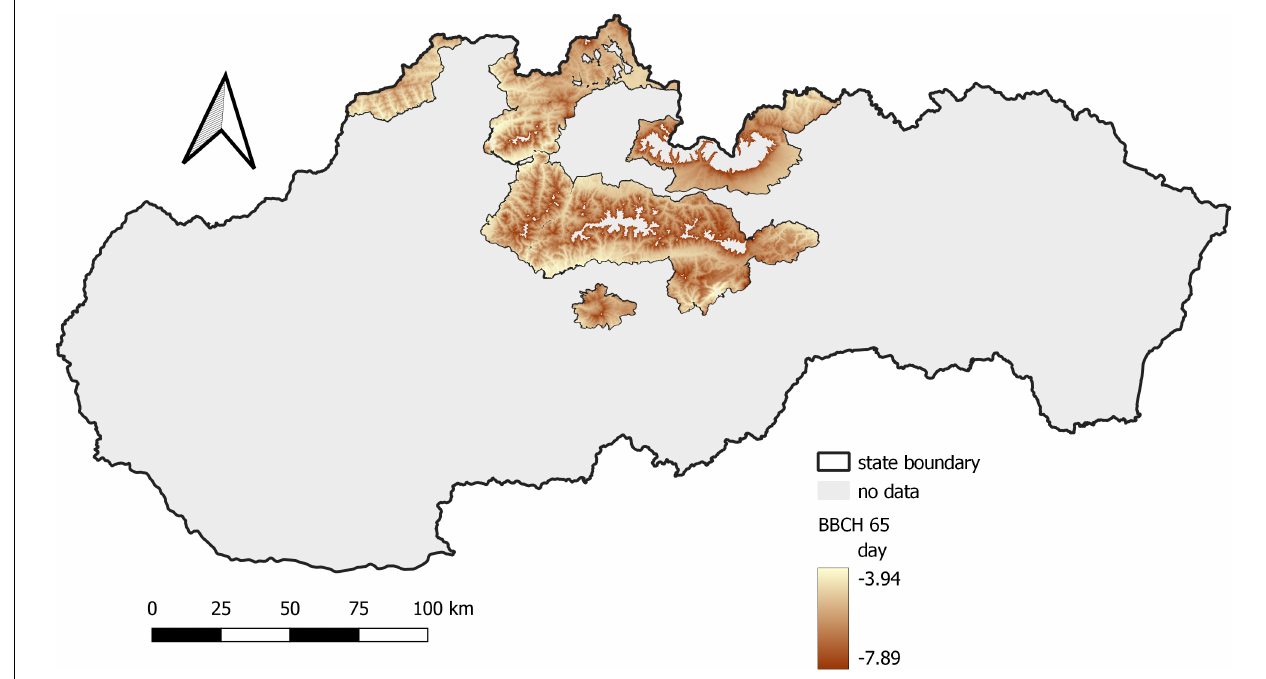
FIGURE 5 | Shift in the average onset of full flowering in Norway spruce between the monitored periods.